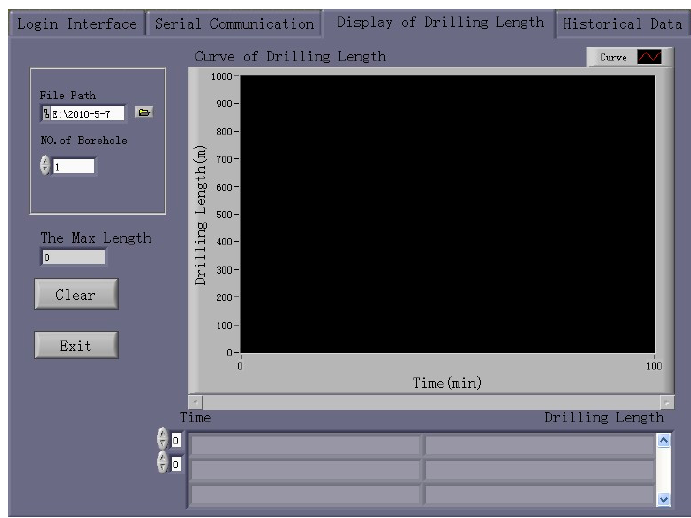
Figure 11. Data display and storage interface of the visual drilling-length management software.